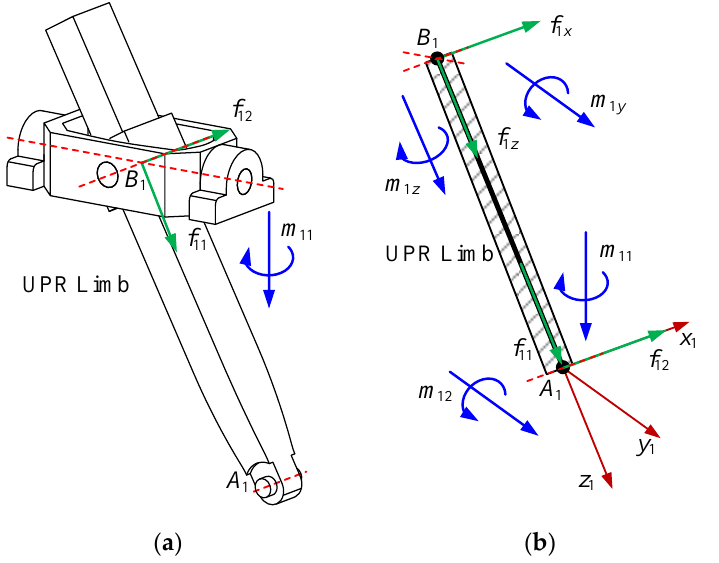
Figure 3. Distributions of wrenches exerted on the UPR limbs: ( a ) wrenches in the UPR limb; ( b ) projections of the wrenches in the UPR limb.